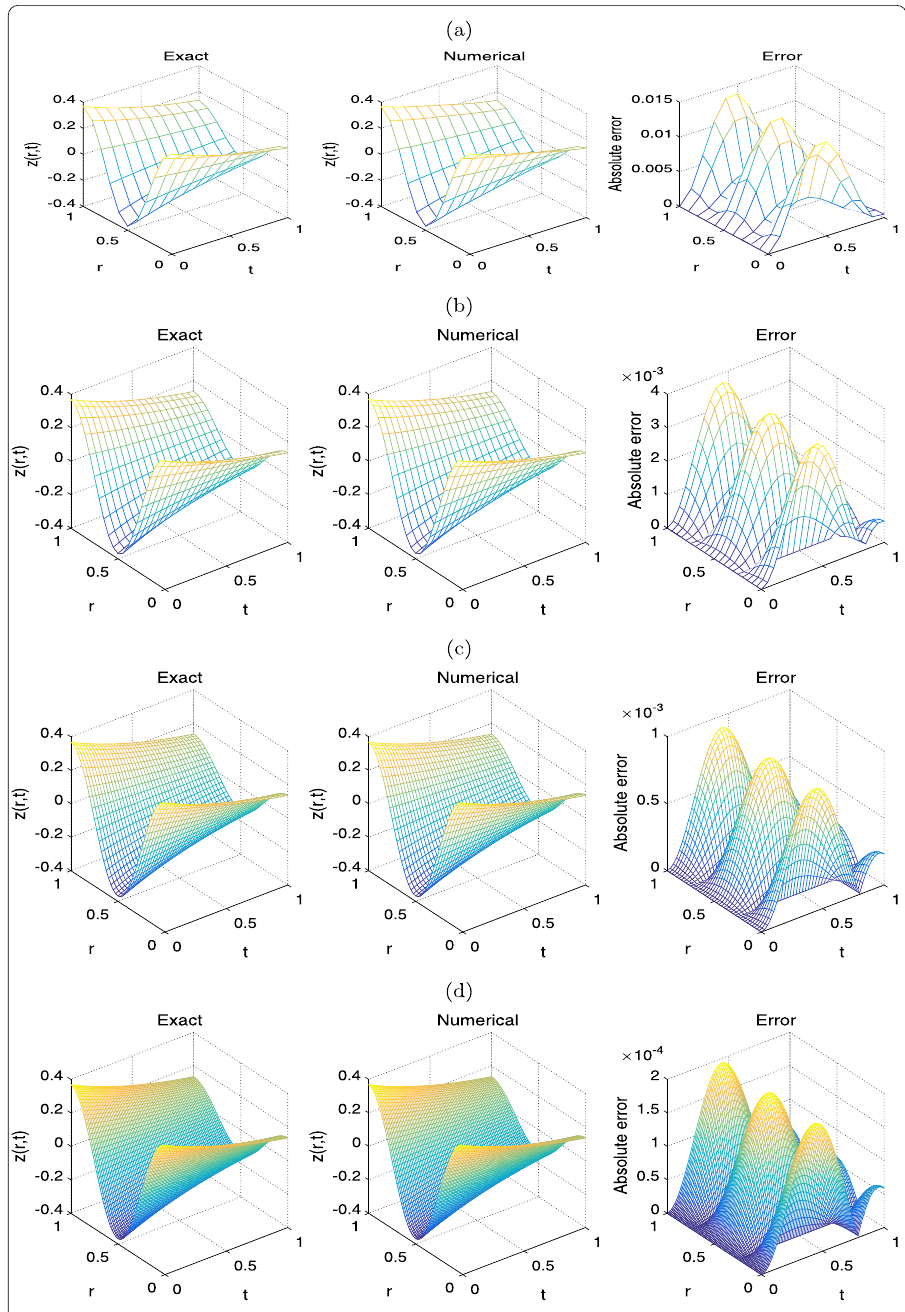
Figure 2 The exact (37) and approximate z ( r , t ), and absolute errors with various grid sizes M = N : ( a ) 10, ( b ) 20, ( c ) 40, and ( d ) 80 for the forward problem